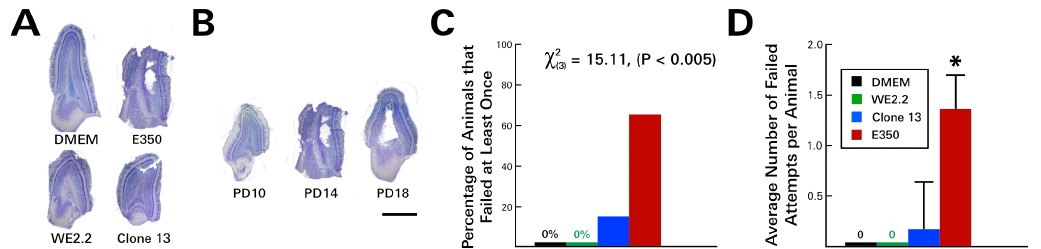
Figure 4. The di ff erent LCMV strains induced di ff erent types of olfactory bulb pathology and di ff erent severity of olfactory discrimination behavioral deficits. ( A ) Nissl-stained 40-micron-thick horizontal sections through the olfactory bulb on PD14. All three viral strains visibly reduced olfactory bulb